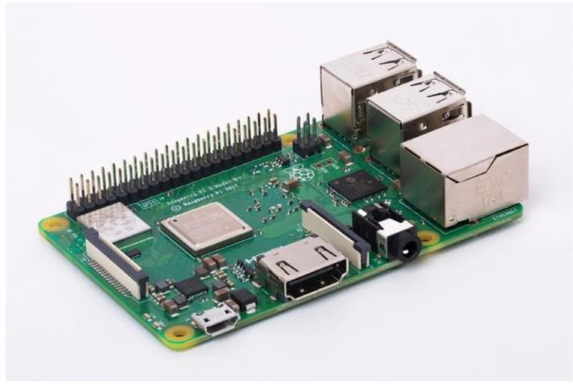
Figure 10. Raspberry Pi 3